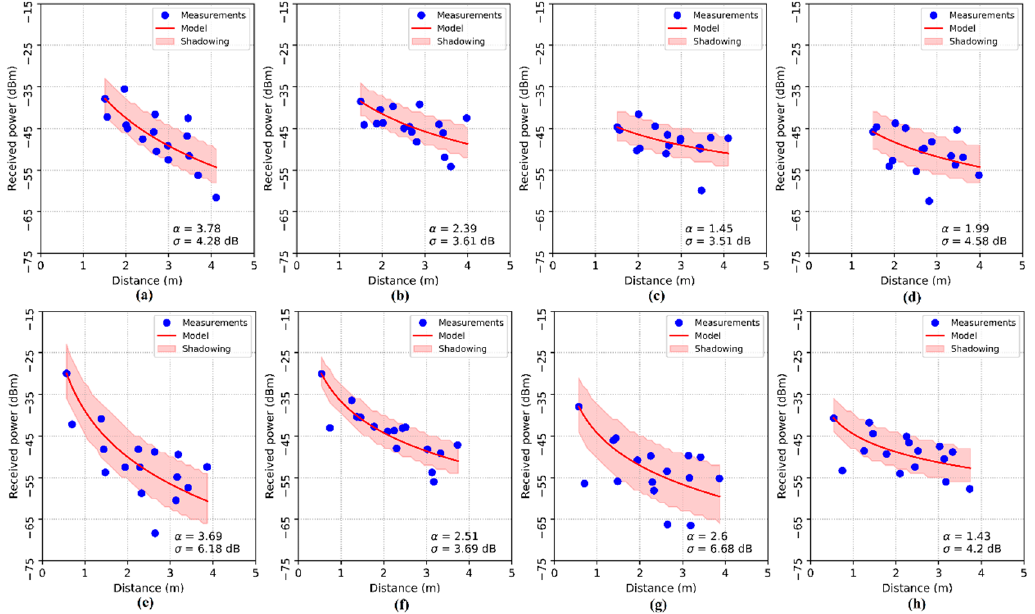
Figure 9. Log-normal shadowing model. The subfigures show the estimated parameters for each access point: ( a ) AP 1, ( b ) AP 2, ( c ) AP 3, ( d ) AP 4, ( e ) AP 5, ( f ) AP 6, ( g ) AP 7 and ( h ) AP 8.